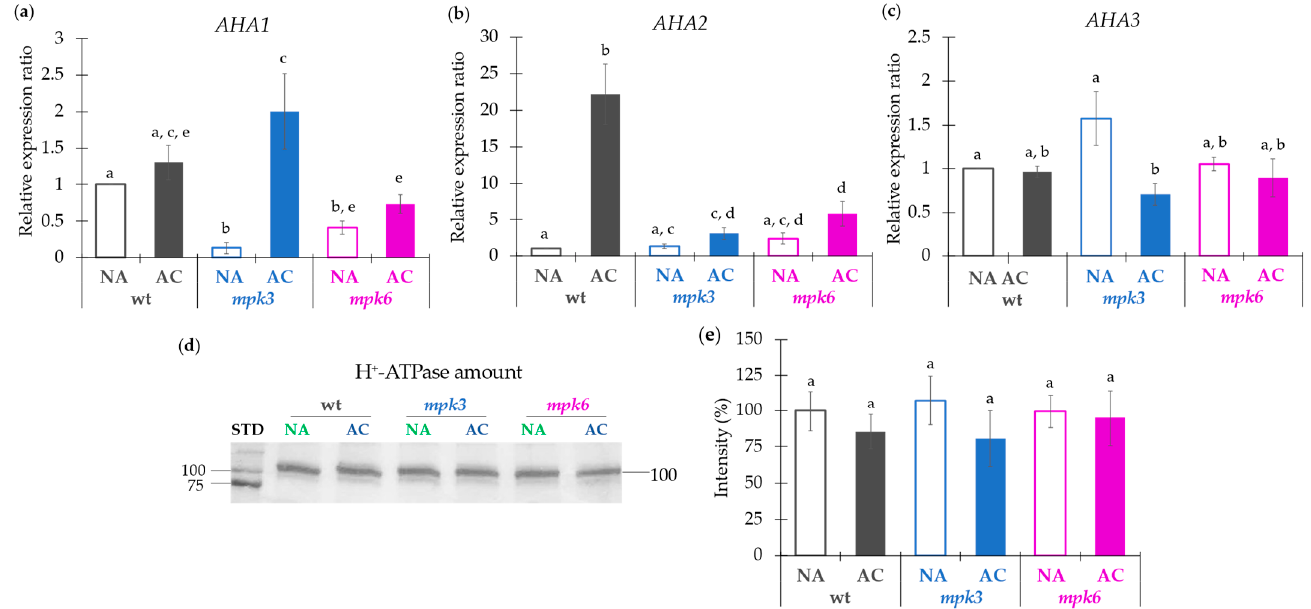
Figure 3. Effect of cold acclimation on the expression of the plasma membrane H + -ATPase isogenes AHA1, AHA2, and AHA3 and on the levels of the plasma membrane H + -ATPase protein in wild type, mpk3 and mpk6 plants. ( a – c ) Expression of AHA1 , AHA2, and AHA3 from NA or AC wild type, mpk3, and mpk6 plants. Plants from the three genotypes were exposed to NA or AC conditions and total RNA was extracted. Relative gene expression of the three isoforms was estimated by qPCR analysis as detailed in Materials and Methods. TUBULIN2 and UBIQUITIN4 were used as housekeeping genes. The expression of the genes in untreated wild type was set to 1.0. ( a – c ) Levels of plasma membrane H + -ATPase protein in PMV isolated from NA or AC wild type, mpk3, and mpk6 plants. ( d ) Immunodetection of the plasma membrane H + -ATPase from the wild type, mpk3, and mpk6 plants exposed to NA or AC conditions. ( e ) Densitometry estimation of the intensity of the bands in ( d ); comparison was done between the band intensity from the NA or AC condition respect to the NA wild type band intensity. Loading control gels are presented in Figure S3a. Normalization of the protein bands in the Western blots was performed considering the intensity of the corresponding lane in the Coomassie stained gel and the blot background when different blots were compared. Values presented in panels ( a – c , e )are means of six replicates from five independent biological samples ± SE. α ≤ 0.05 (ANOVA test). Different letters indicate significant differences.